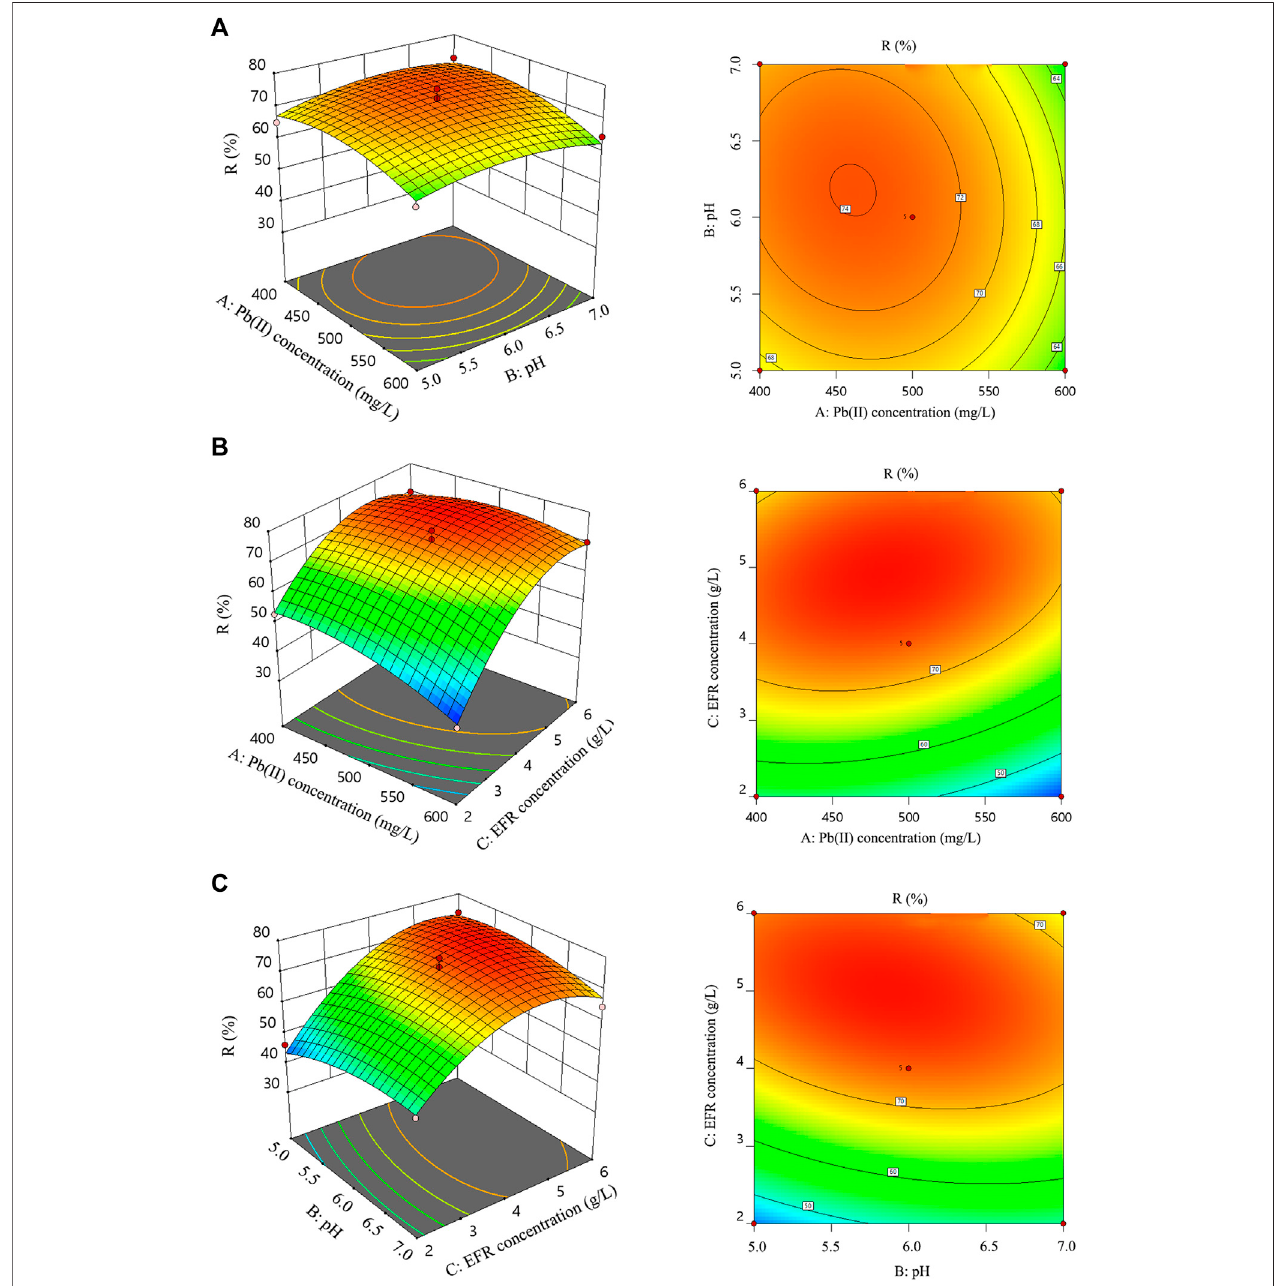
FIGURE3| Thetwo-andthree-dimensionalmodelforPb(II)adsorptionbyEFR.TheresponsesurfacemodelwasobtainedbytheBBDdesignwiththedatashown in Table2 . (A) :RofPb(II)asafunctionofPb(II)concentrationandpHvalue; (B) :RofPb(II)asafunctionofPb(II)concentrationandEFRconcentration; (C) :RofPb(II)asa function of pH value and EFR